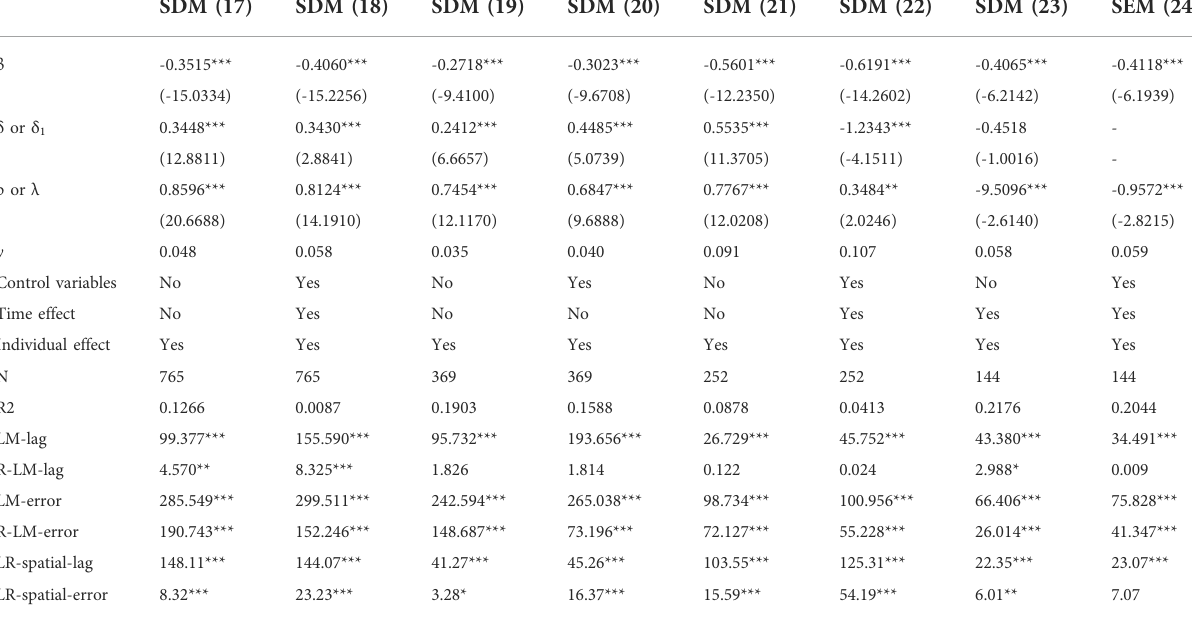
TABLE 8 Robustness test